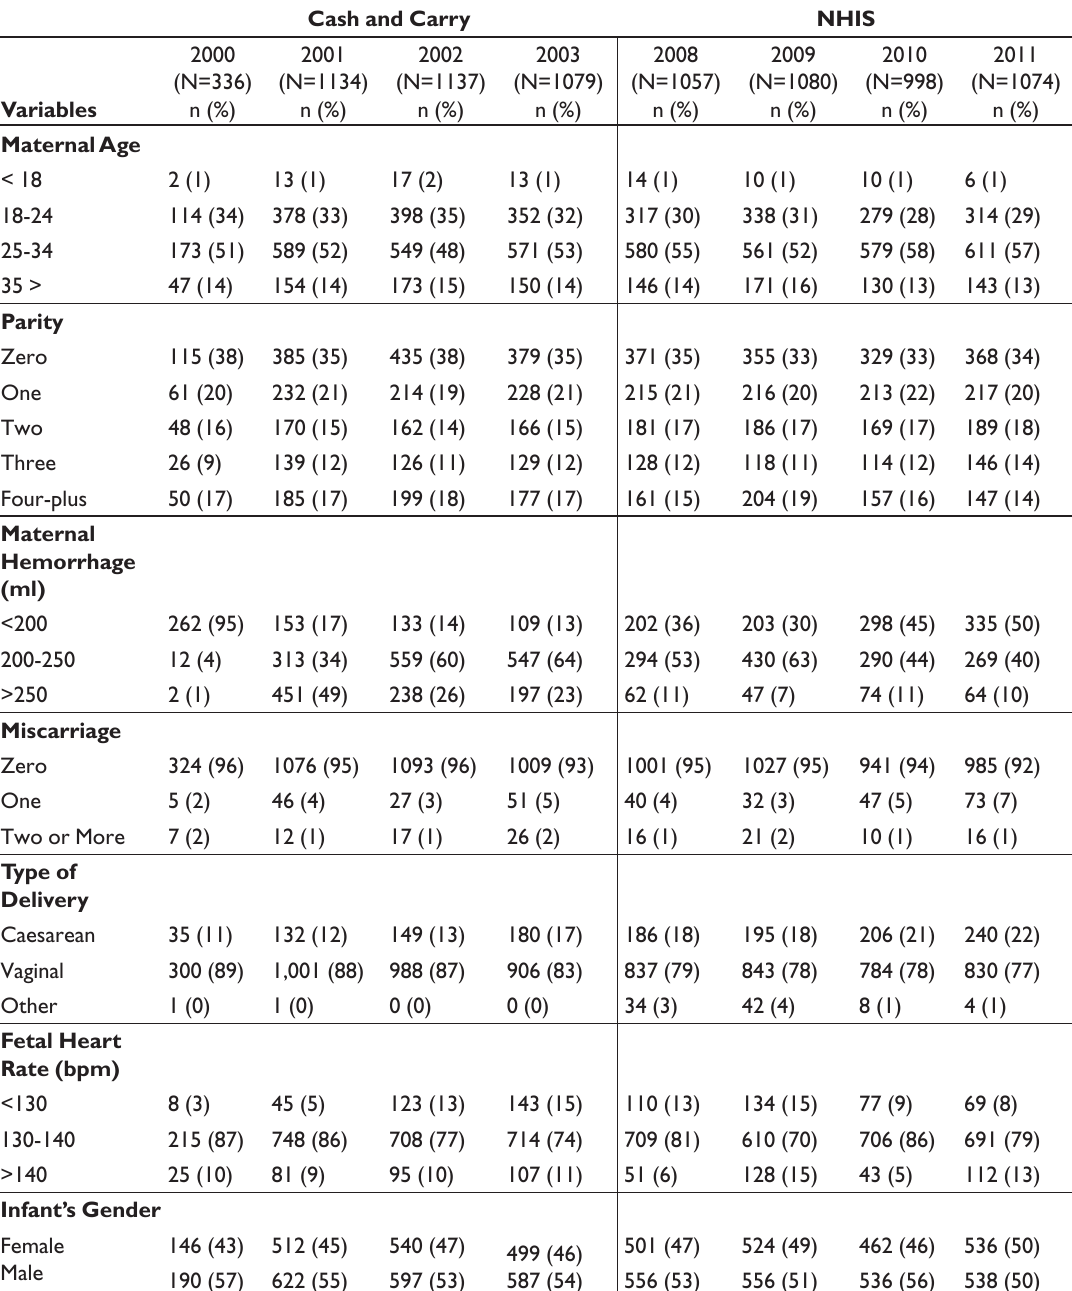
Characteristics of all live births under Cash and Carry and NHIS systems at Tamale Teaching Hospital in Northern Ghana Cash and